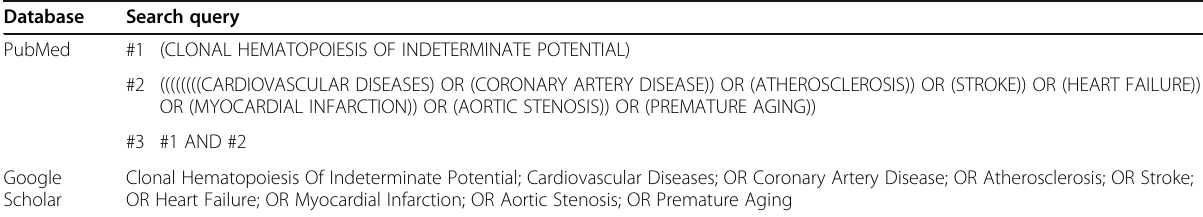
Table 1 Search strategy